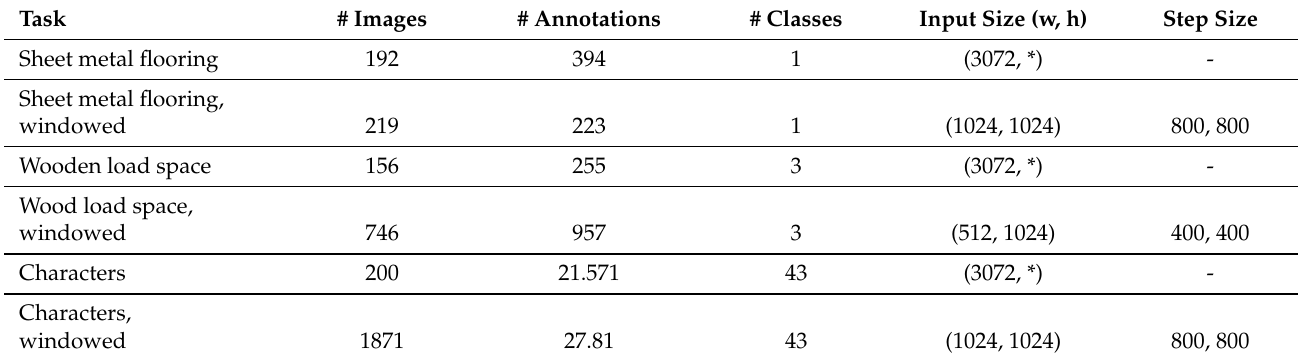
Table 2. Characteristics of the datasets utilized in this